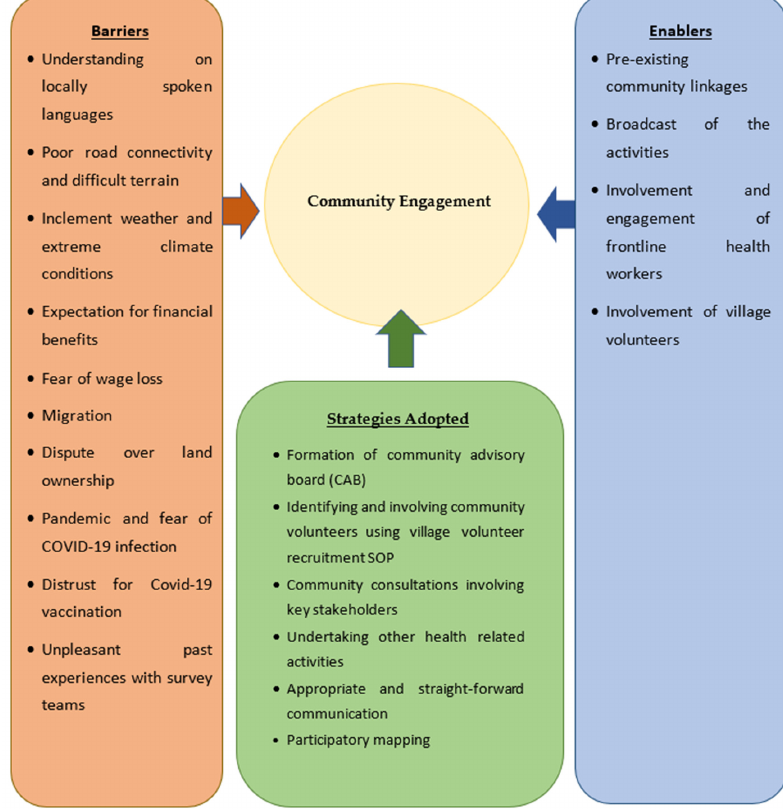
Figure 3. Conceptual framework showing barriers, enablers, and strategies for enhanced community engagement. A comparison od the barriers and enablers encountered, and strategies adopted for better community engagement, across the six DDESS sites, is presented in Table 2.